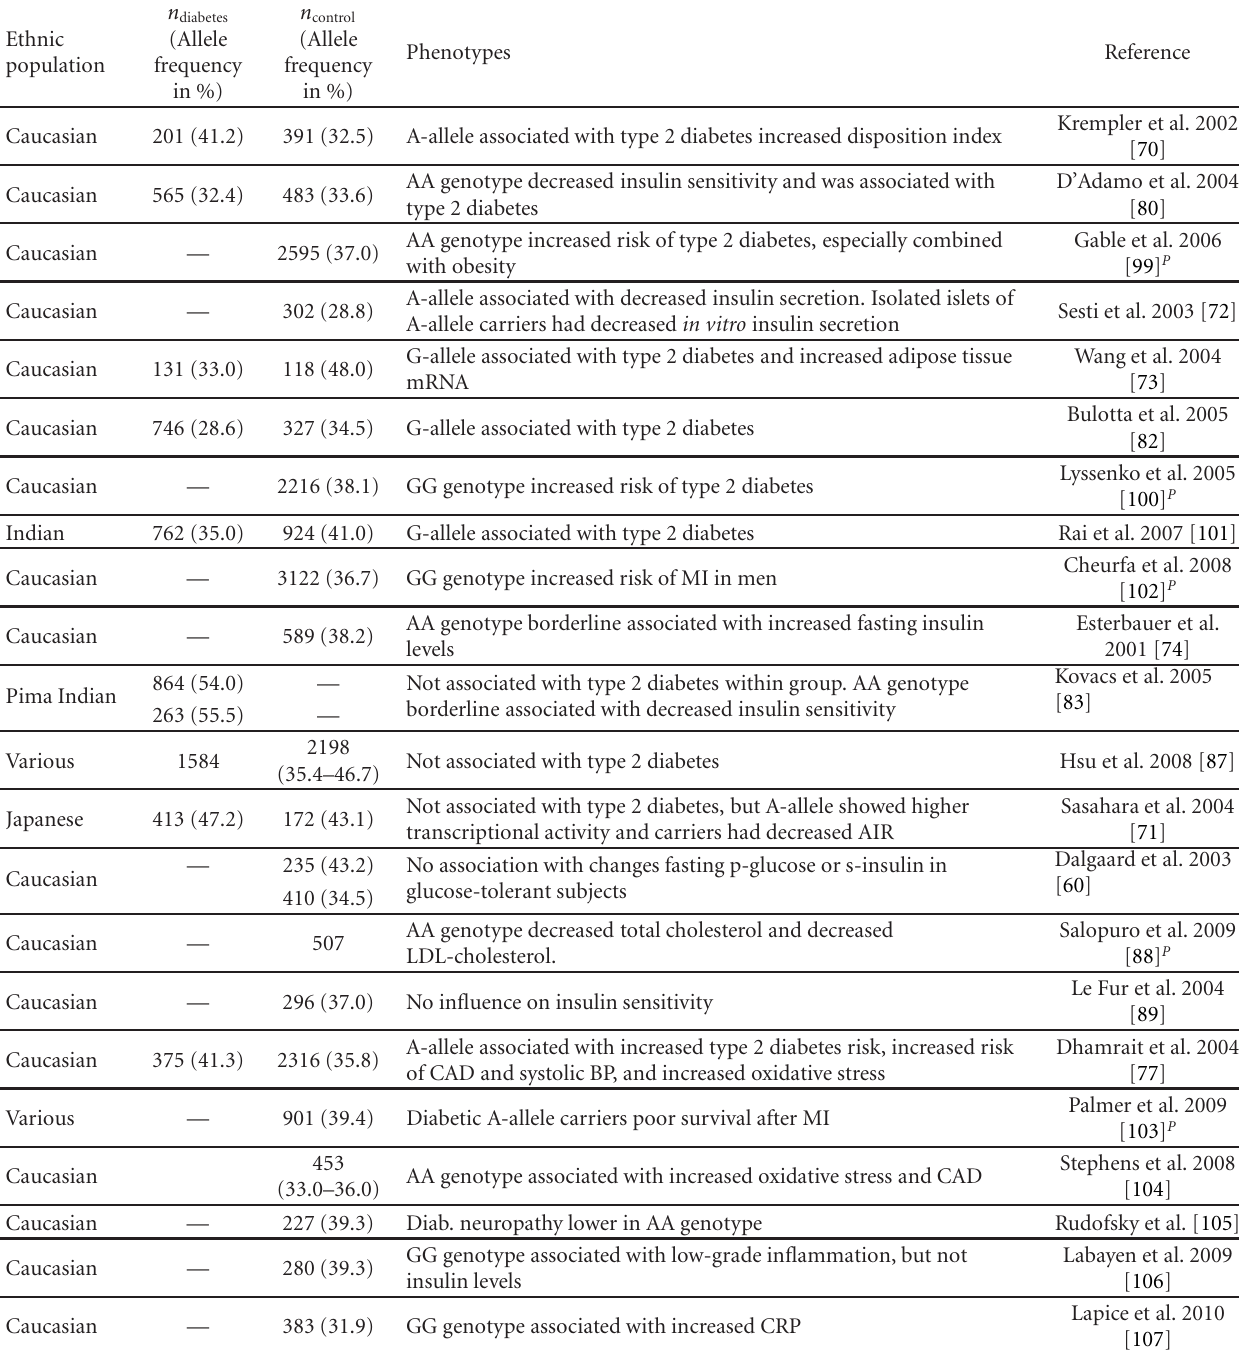
Table 3: Summary of association or prospective studies of the UCP2 promoter − 866G > A (rs659366) polymorphism in relation to type 2 diabetes and intermediary